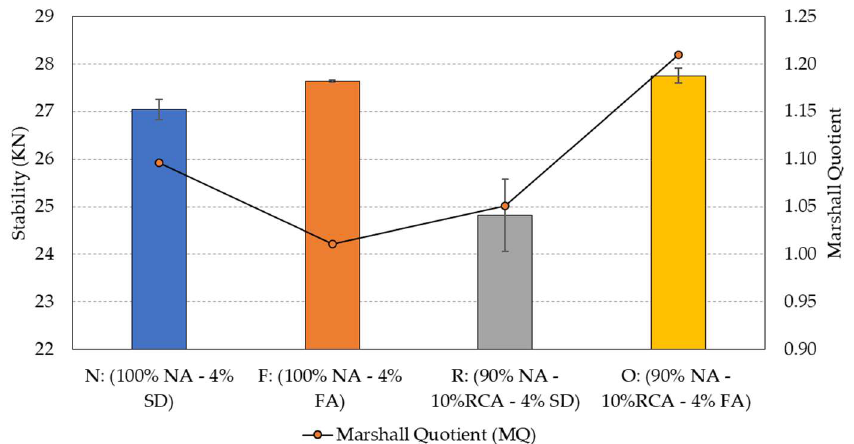
◦ C of the four porous asphalt mixtures.